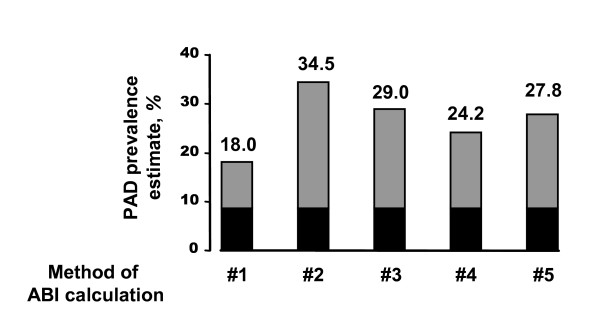
Prevalence estimates for PAD using different methods for ABI calculation. PAD was defined by an ABI value < 0.9 (grey bars) or clinical evidence of PAD (black bars). Clinical evidence of PAD included positive Rose questionnaire, intermittent claudication and peripheral vascular event.